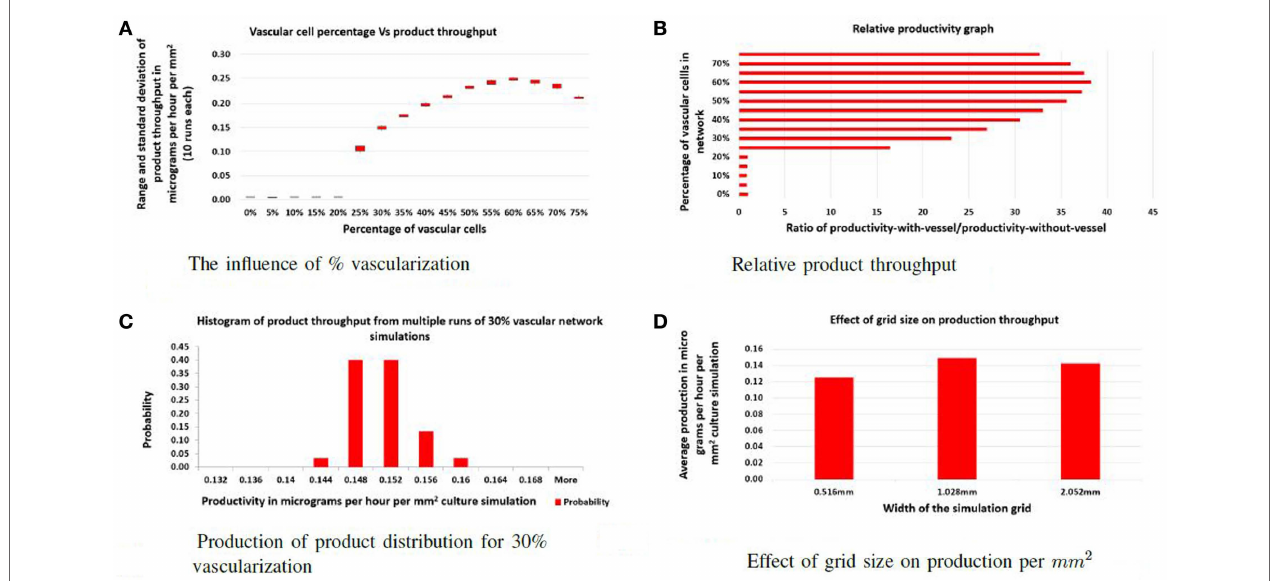
FIGURE 2 | Evaluation: (A) the effect of varying the percentage of vascular cells in the initial random configuration on the total product throughput per hour; (B) the effect of varying the percentage of vessel cells in the initial random configuration on relative productivity . Productivity is measured by dividing throughput of the specific experiment with the throughput of the factory with no vascular system; (C) illustration of the robustness of the self-organizing process as a histogram of product throughput from networks generated with different random seeds; (D) the effect of increasing the width of the culture. Here, the actual productivity is given in micrograms per hour per cubic micrometer of culture.